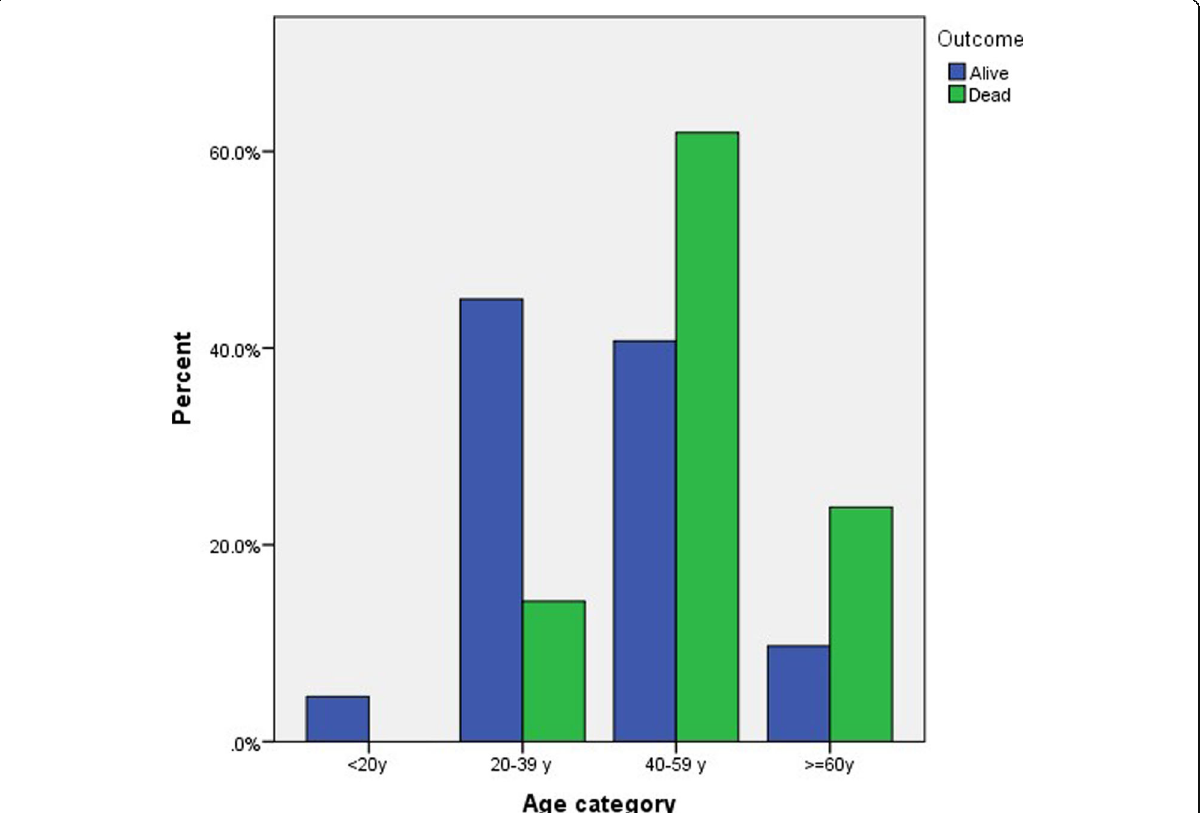
Fig. 12 Percentage distribution of outcome according to age